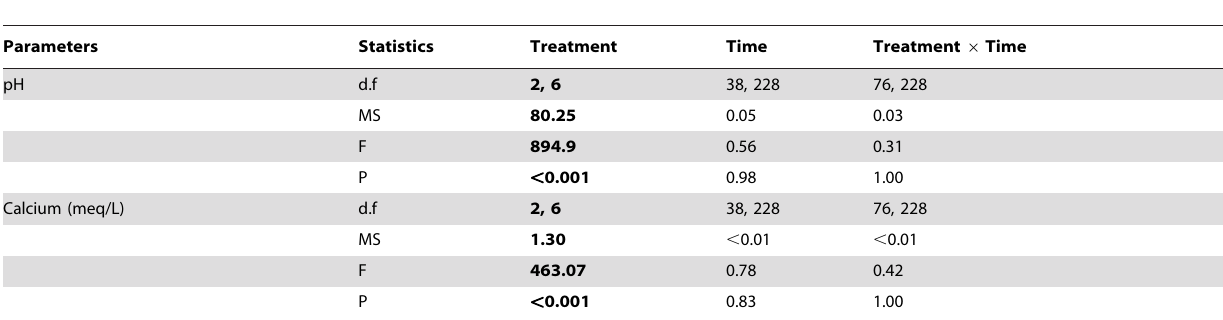
Table 3. Results of repeated-measures ANOVA contrasting water quality variables (pH and calcium concentration) between lakes (circum-neutral, acidified and limed), time (year) and their